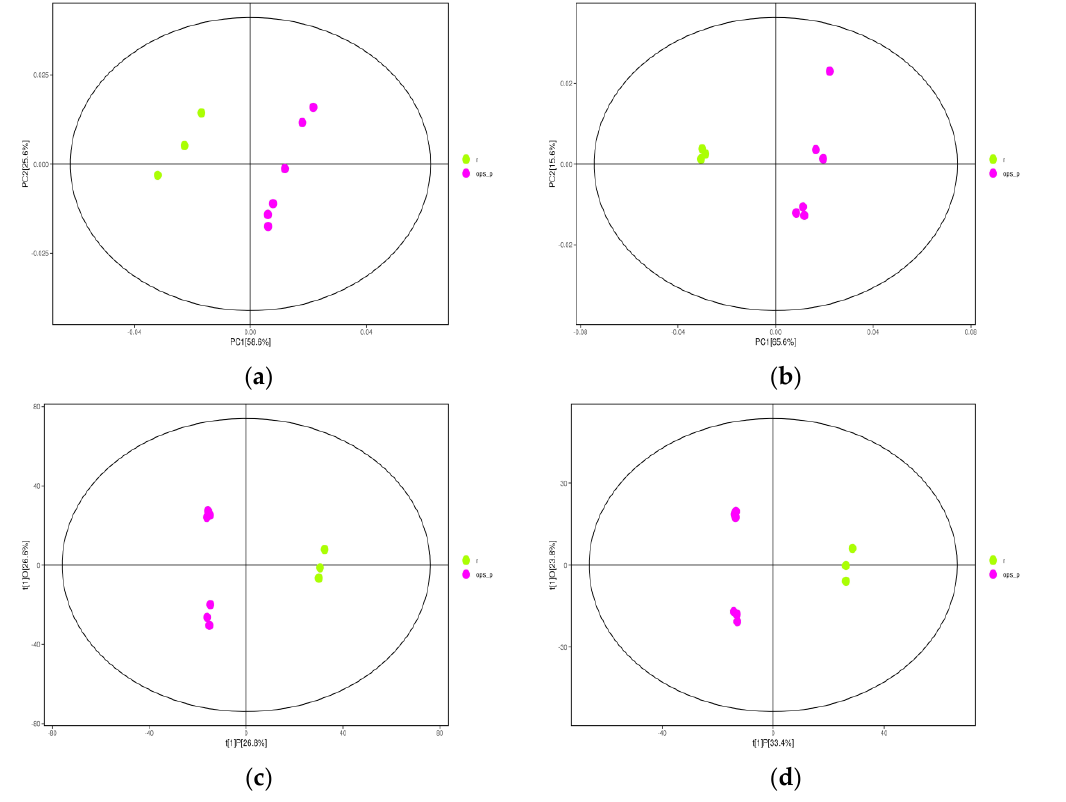
Figure 2. Dispersion point diagrams of the positive ion PCA and OPLS − DA of raw, steamed, and cooked black beans. ( a ) Dispersion point diagram of PCA in positive ion mode. ( b ) Dispersion point diagram of PCA in negative ion mode. ( c ) Dispersion point diagram of OPLS − DA in positive ion mode . ( d ) Dispersion point diagram of OPLS−DA in negative ion mode.